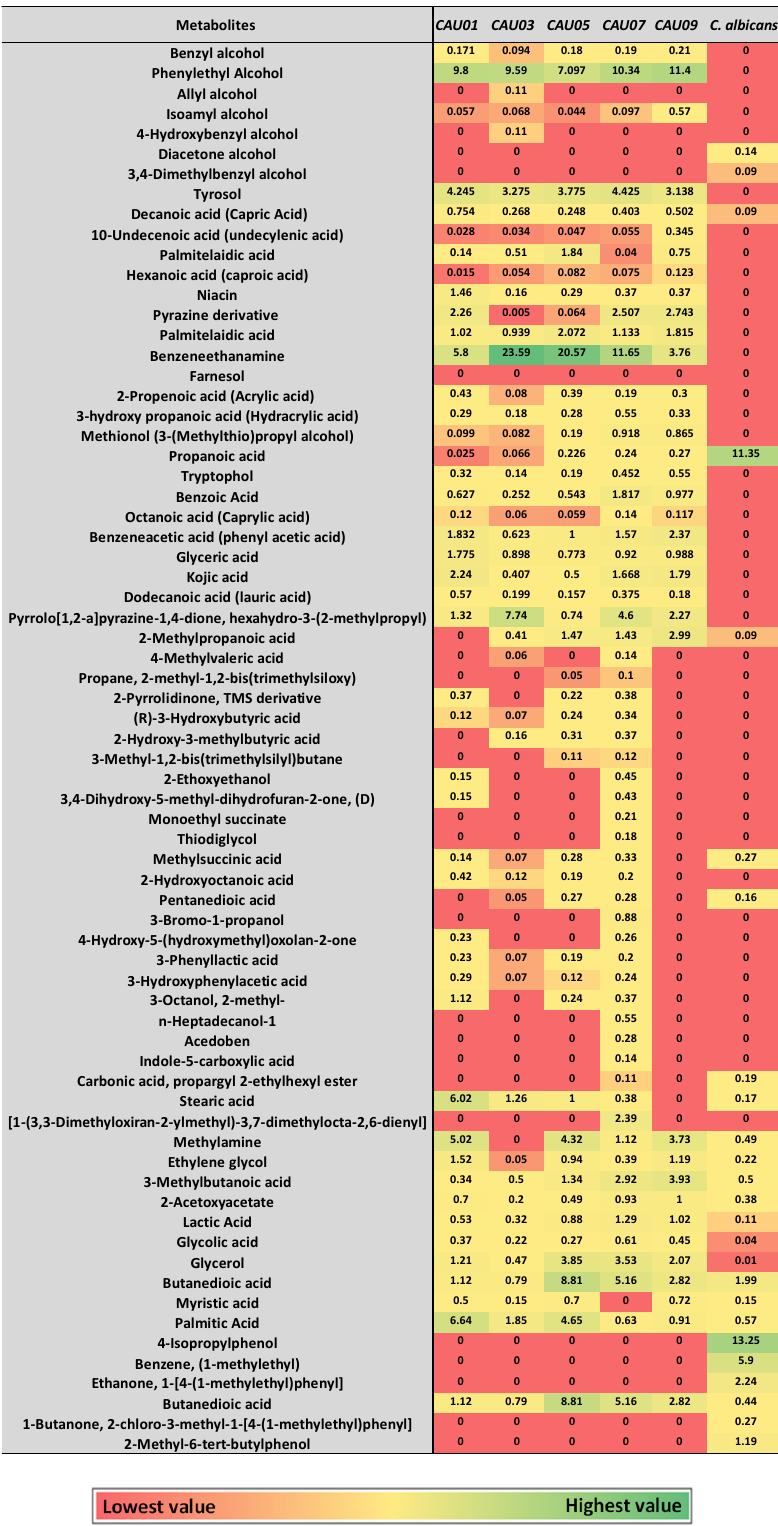
Figure 3. Heatmap of major identified metabolites in Candida cultures by GC-MS. Metabolite average relative percentage of four experimental replicates from two independent biological experiments were displayed as colors ranging from red to green as shown in the key. The relative percentage of a metabolite represented in relation to total areas of all detected metabolites in an extract.